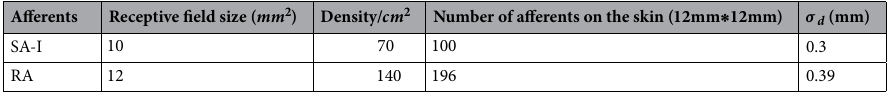
Table 2. Afferent properties used in the simulations 8 .